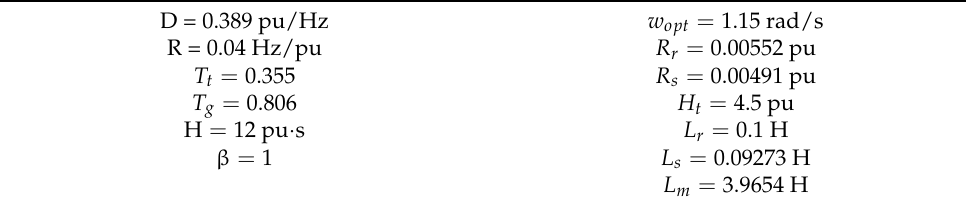
Table 2. Model parameters of the power system with wind turbines. D = 0.389